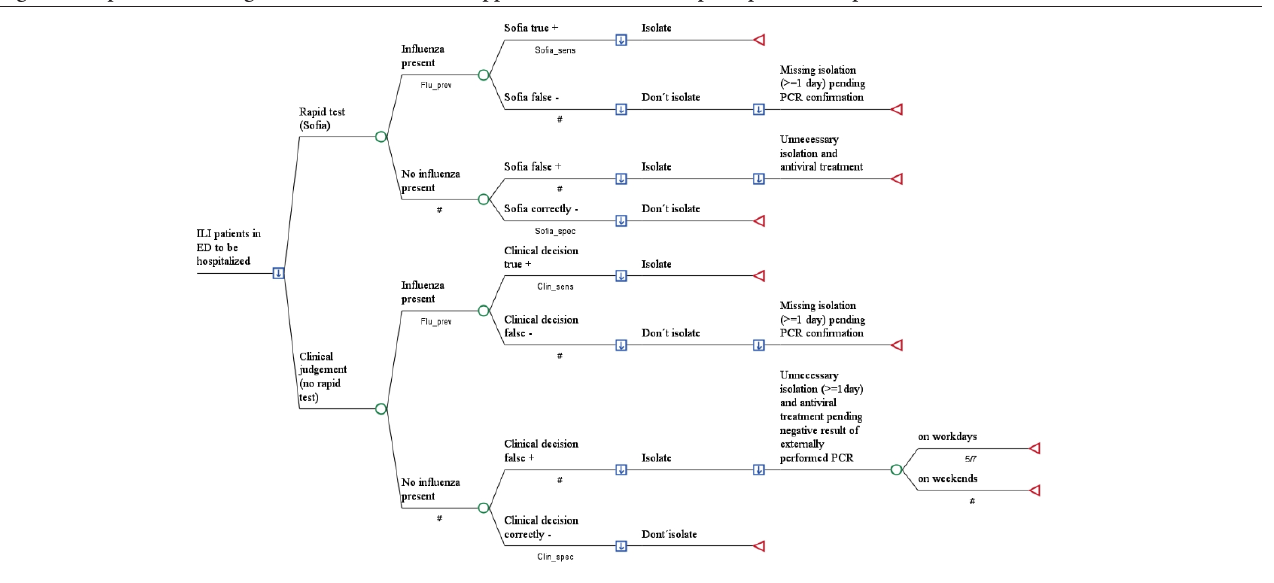
Figure 1. Rapid POC testing versus the conventional approach in influenza suspects prior to hospitalization.